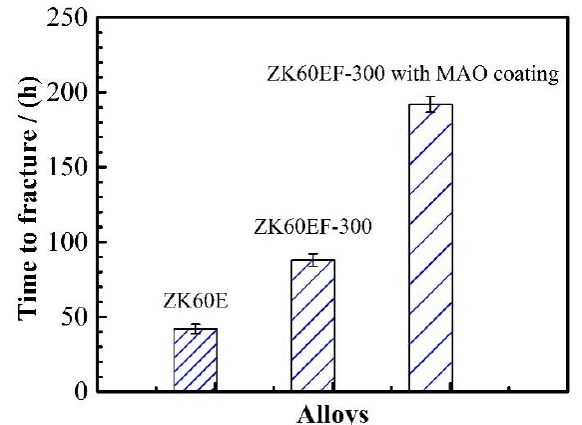
Figure 14. The time to fracture for ZK60E, ZK60EF-300, and MAO-coated ZK60EF-300 alloys in 3.5 wt.% NaCl solution under 80 MPa stress.